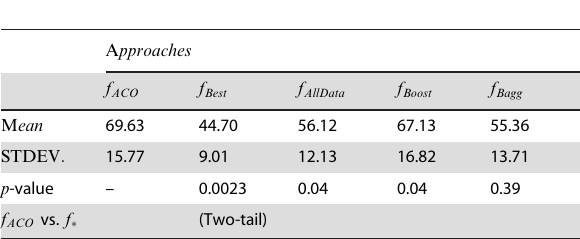
Table 9. Experimental results for HD prediction problem. Accuracy percentage values of ACO and benchmark